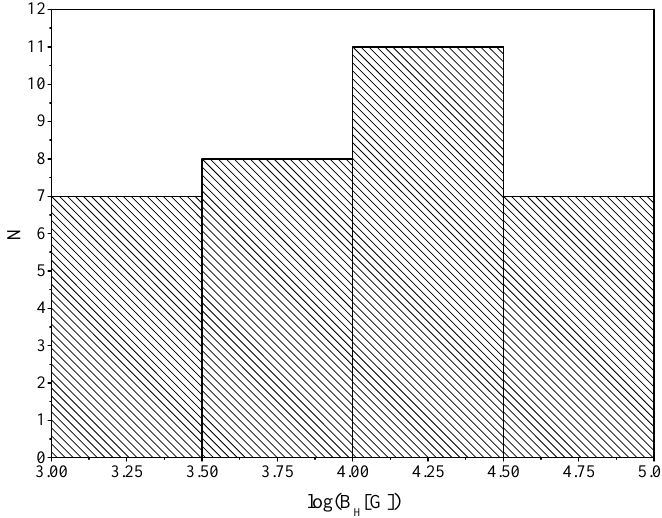
Figure 12. A histogram showing the number of objects with a certain B H value.